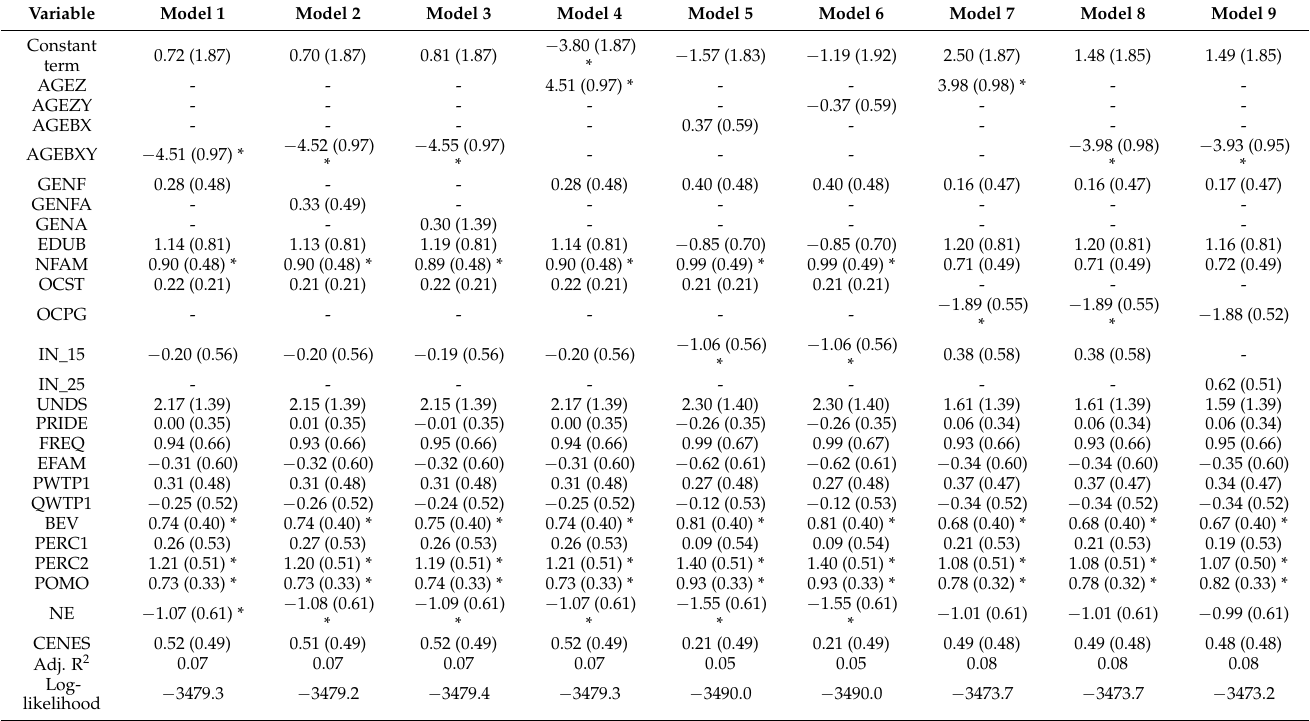
Table 6. The empirical results of MWTP in the case of cassava